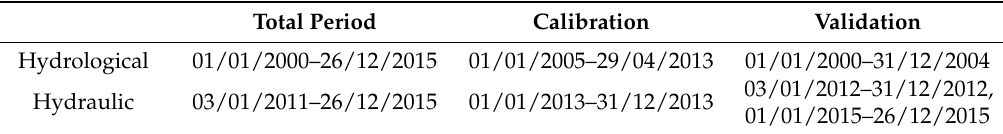
Table 2. Calibration and validation period for the hydrological and hydraulic